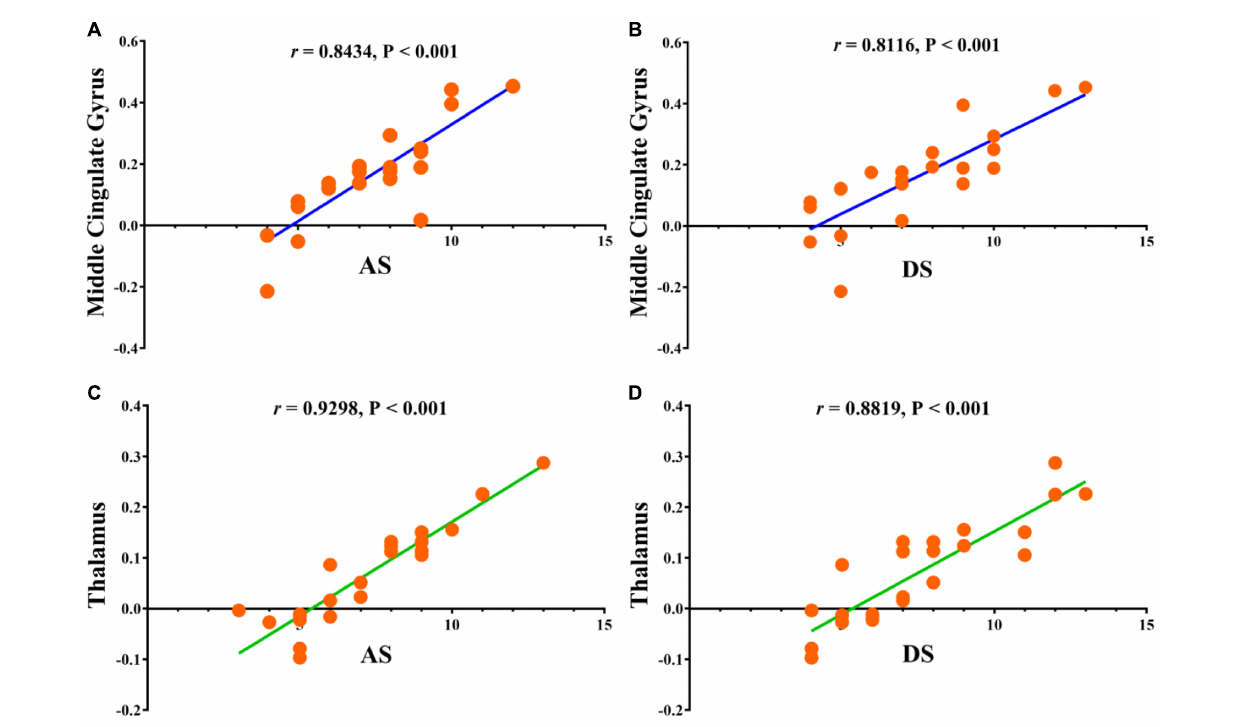
FIGURE 5 | Correlations between the clinical behaviors and FC values in middle cingulate gyrus and thalamus. (A) The anxiety scores showed a positive correlation with FC values in middle cingulate gyrus (0.8434, 95% CI: 0.6610–0.9317); (B) the depression scores showed a positive correlation with FC values in middle cingulate gyrus (0.8116, 95% CI: 0.6002–0.9170); (C) the anxiety scores showed a positive correlation with FC values in thalamus (0.9298, 95% CI: 0.8392–0.9702); (D) the depression scores showed a positive correlation with FC values in thalamus (0.8819, 95% CI: 0.7380–0.9491). FC, functional connectivity; AS, anxiety scores; DS, depression scores.